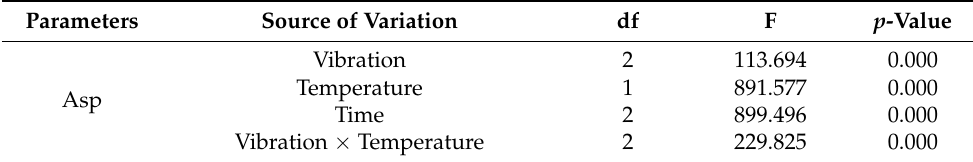
Table 1. The interaction results of vibration frequency, temperature, and transport time on FAAs, water quality parameters, blood biochemical parameters, and oxidative stress are shown below.